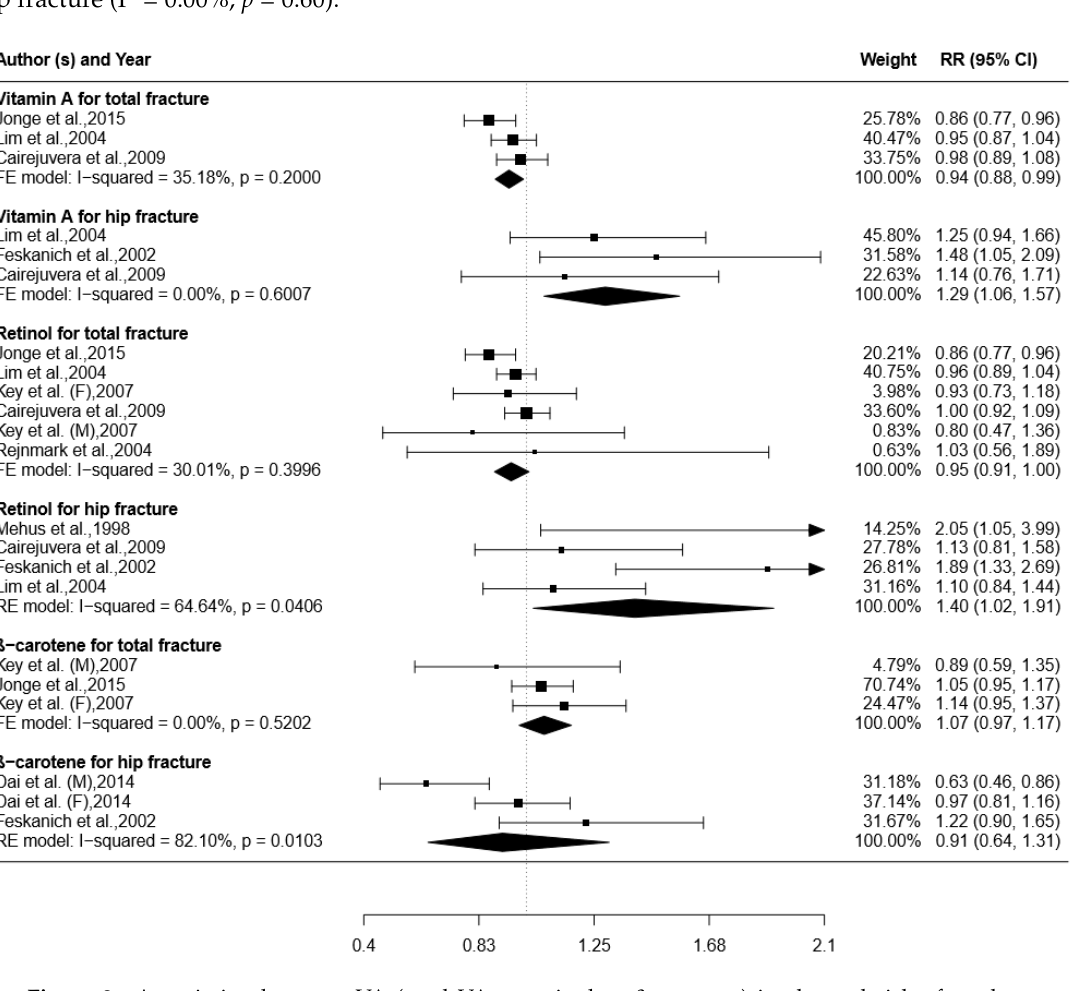
Figure 2. Association between VA (total VA or retinol or β-carotene) intake and risk of total or hip fracture. Boxes represent RR for each individual study; horizontal lines represent 95% CI; arrows indicate CI larger than 2.1; rhombus represent the combined RR with 95% CI.